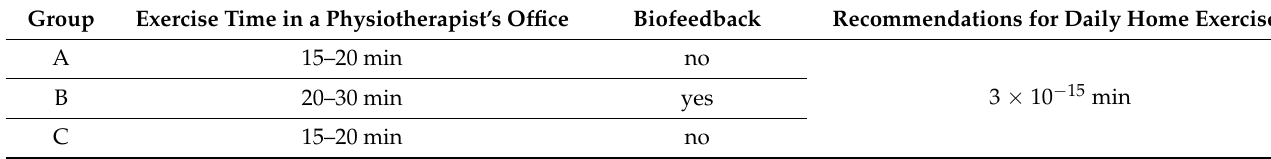
Table 2. Exercise time in individual groups and the use of